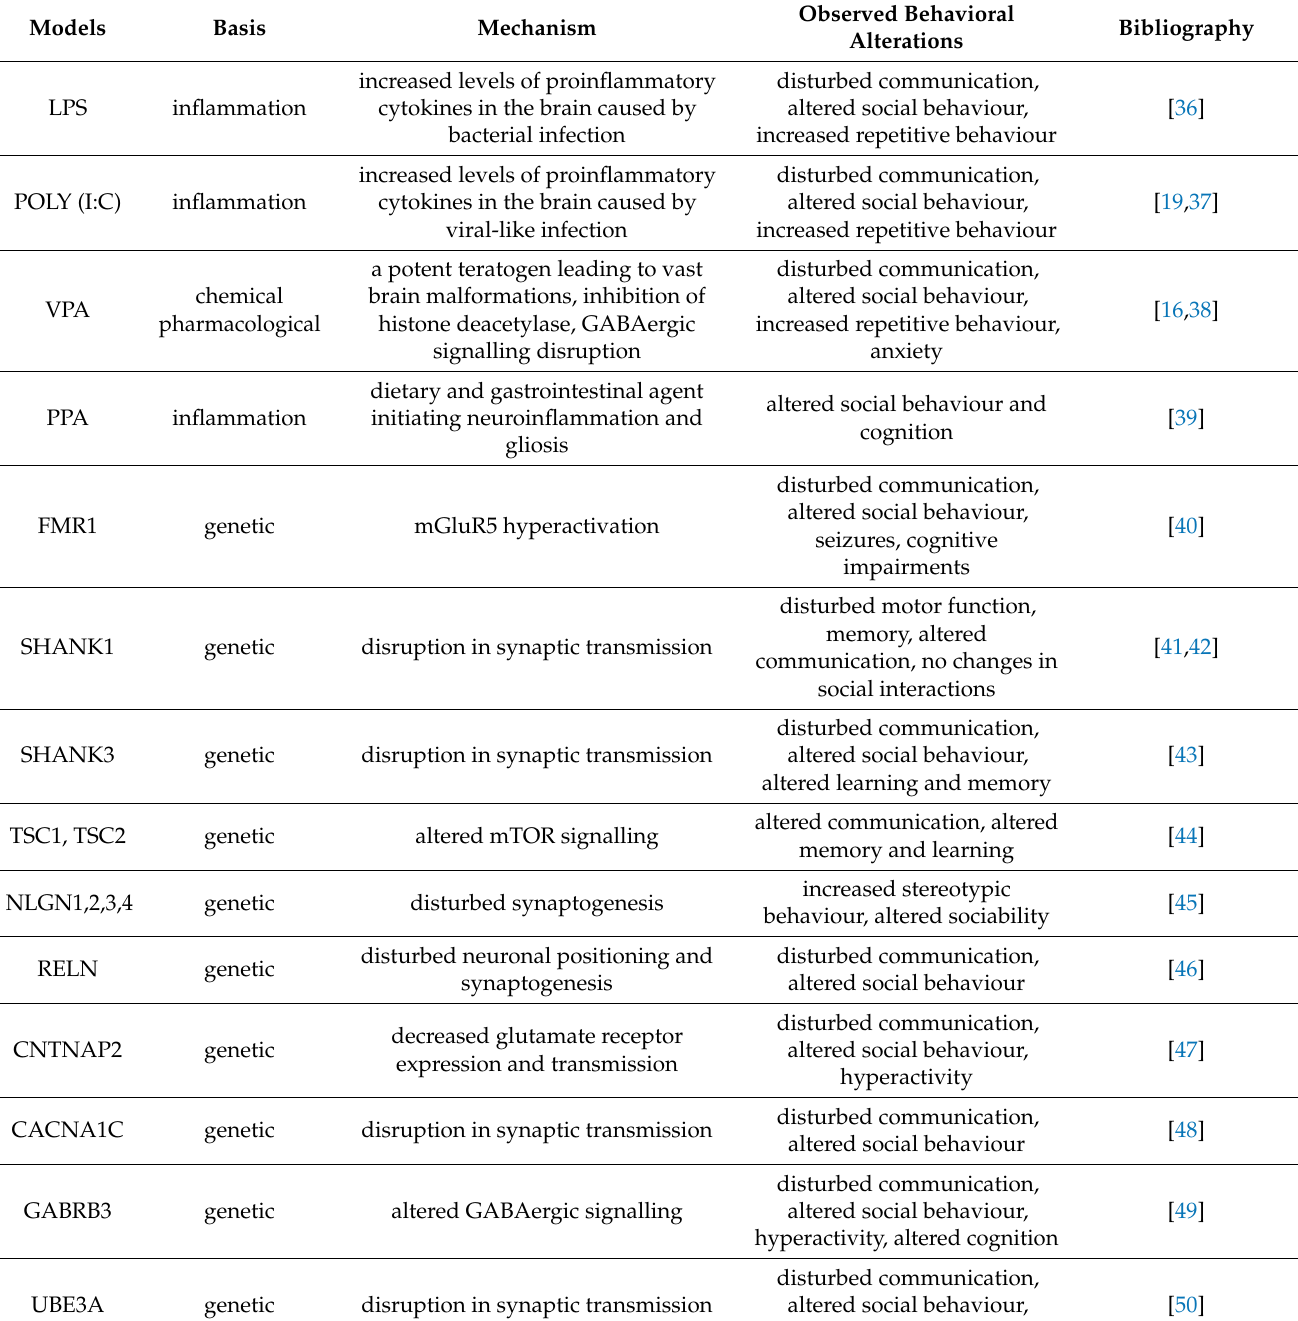
Table 1. A short list of the chosen animal models of